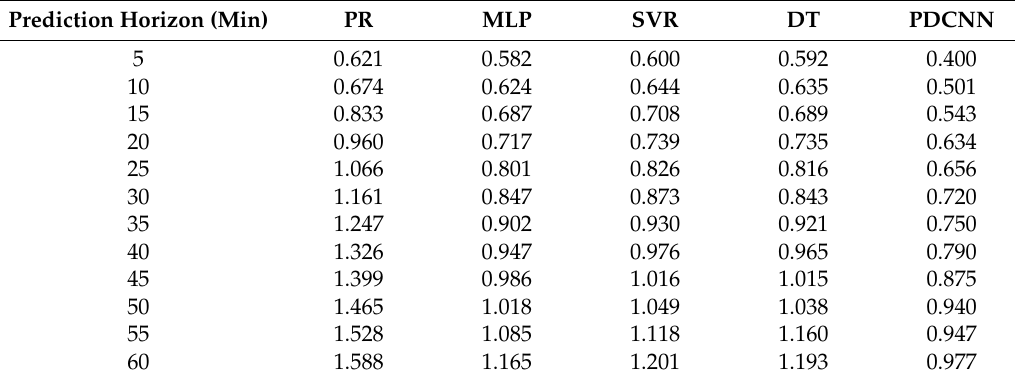
Table 3. A-RMSE of Prediction Models for Different Time Horizons